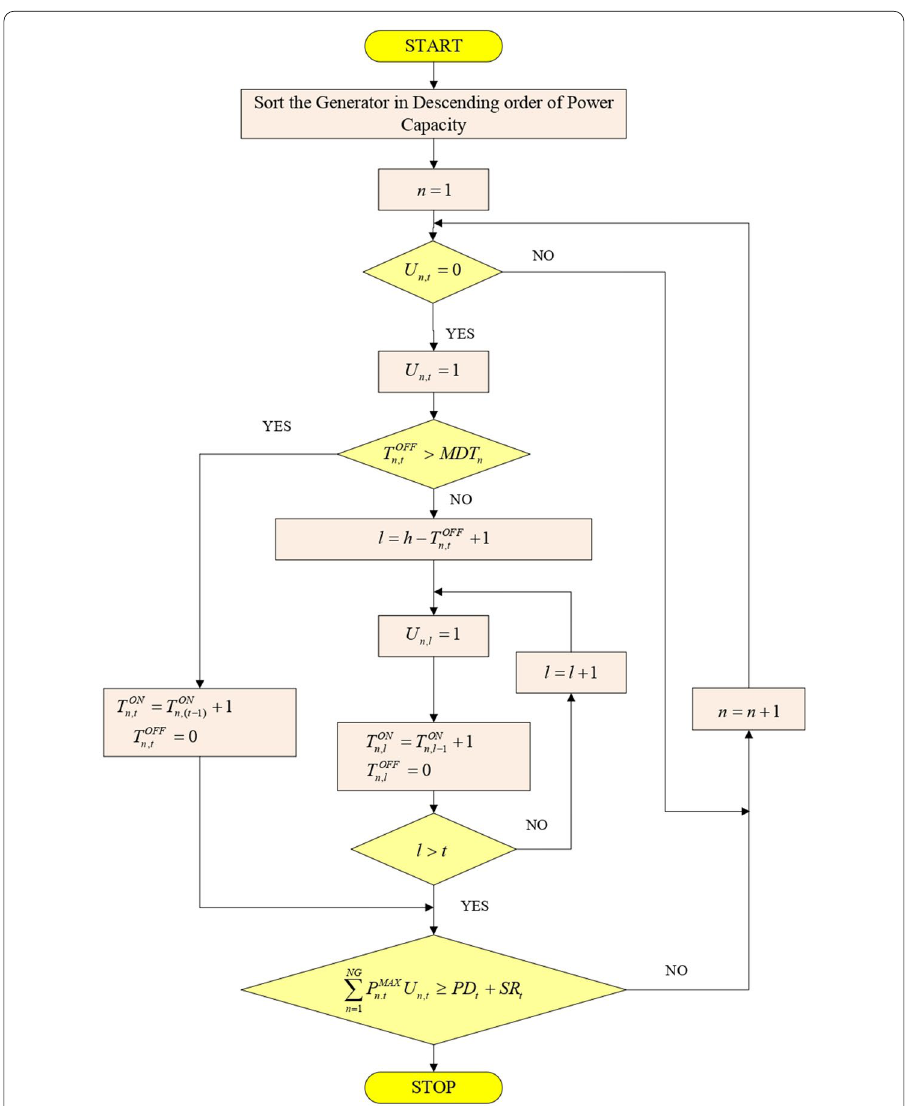
Fig. 8 Flowchart for repairing spinning